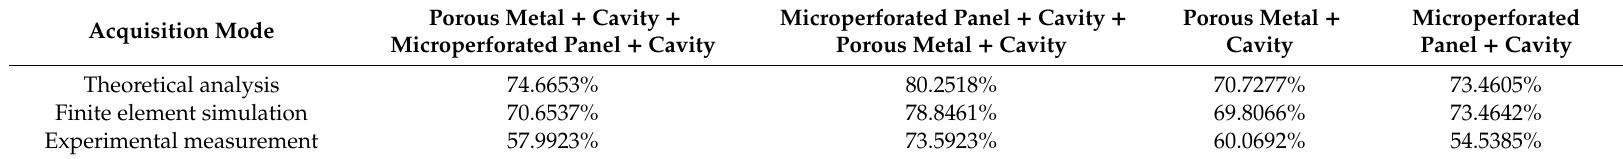
Table 5. The average sound absorption coe ffi cients when the limited total thickness was 50